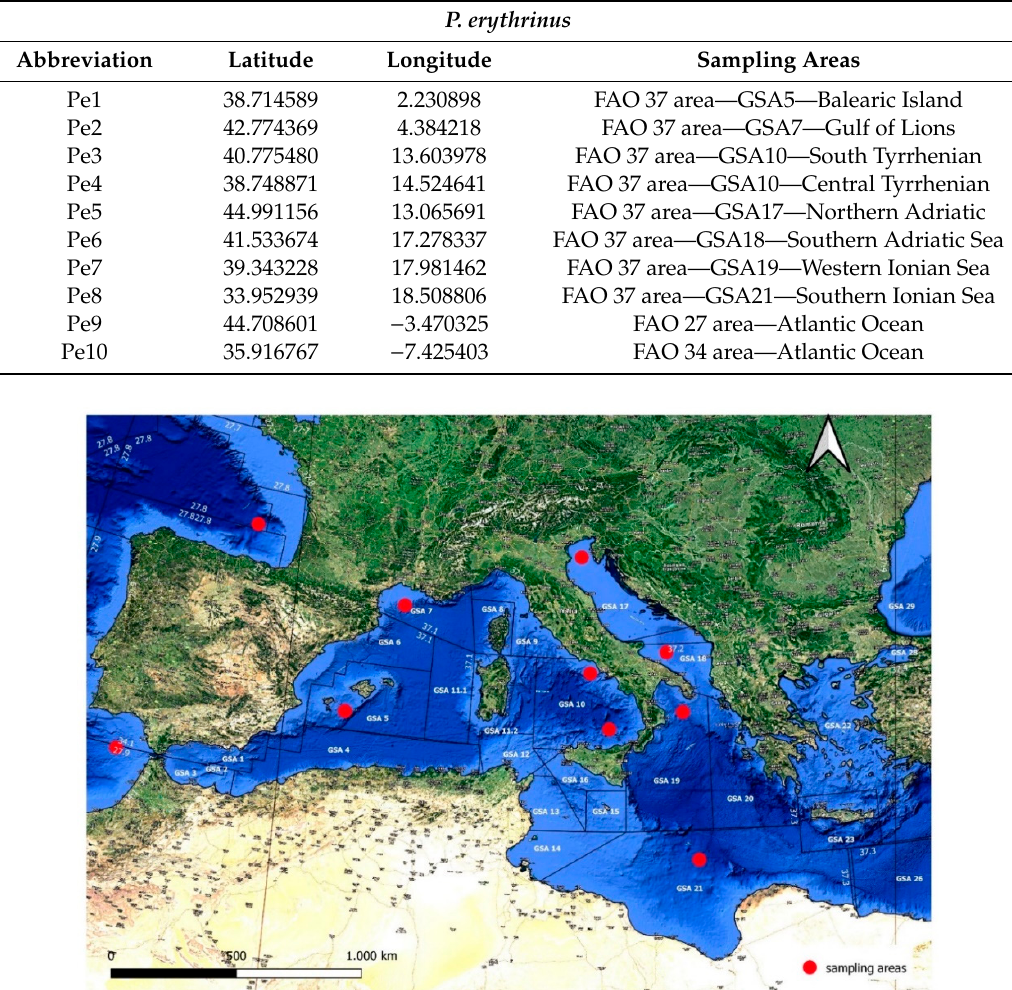
Figure 1. Red spots show the geographical origins of the P. erythrinus specimens sampled for this study. The sampling areas considered the GSA division from GFCM (Establishment of Geographical Sub ‐ Areas in the GFCM area amending the resolution GFCM/31/2007/2) and FAO areas. GFCM: General Fisheries Commission for the Mediterranean. GSA: Geographical Sub ‐ Area.